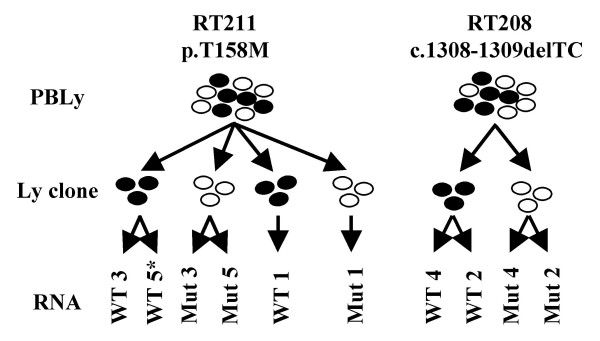
Experimental design of T-lymphocyte clone isolation. Two technical replicate hybridizations for the wild type MECP2 and mutant MECP2-expressing clonal cell-cultures (RT211 with p.T158M mutation and RT208 with c. 1308-1309delTC mutation) were performed, as well as a biological replicate hybridization with an independent clone of patient RT211. (PBLy = peripheral blood lymphocytes; Ly clone = T-lymphocyte clone; * indicates unused in array hybridization analysis because of insufficient RNA quality)